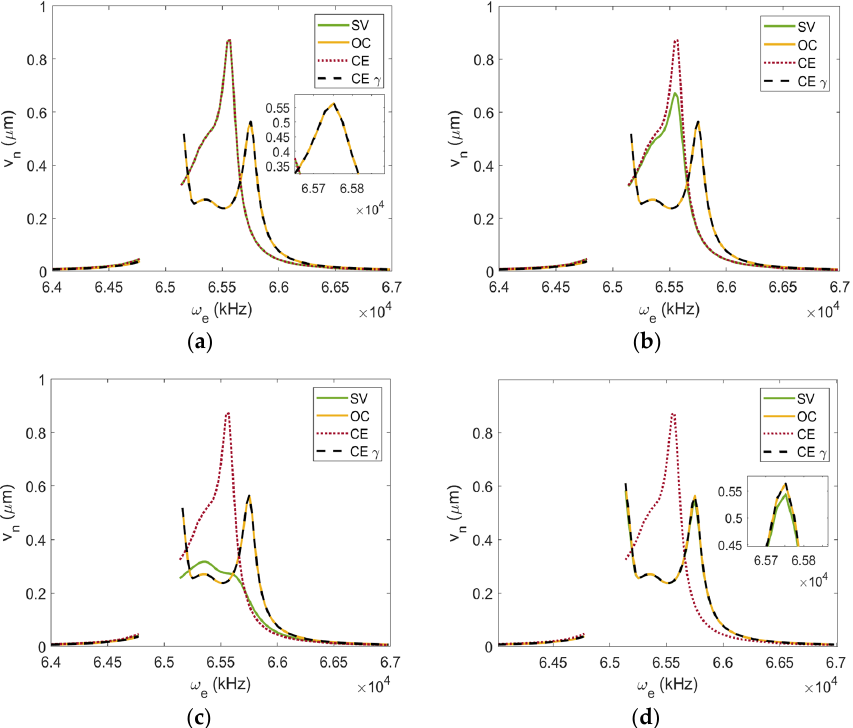
Figure 9. Sensing displacement variations as a function of the excitation frequency: ( a ) 𝑅 = 10 (cid:2871) Ω , ( b ) 𝑅 = 10 (cid:2873) Ω , ( c ) 𝑅 = (cid:2869) Ω , and ( d ) 𝑅 = 10 (cid:2876) Ω when 𝑉 (cid:3005)(cid:3004) = 1𝑉 , 𝑉 (cid:3002)(cid:3004) = 0.5 V, Ω = 80 (cid:3045)(cid:3028)(cid:3031) (cid:3004) (cid:3291) (cid:3104) (cid:3289) 0.01 .